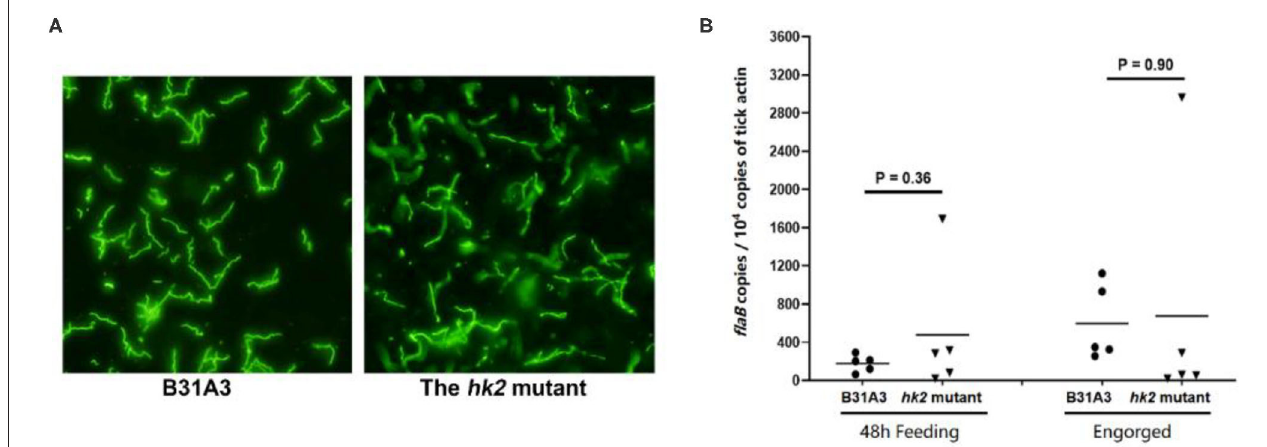
FIGURE 1 | IFA and qPCR analyses of spirochetes in fed larvae. (A) Unfed I. scapularis larvae harboring either the wild type B31A3 or the hk2 mutant were fed on naive C3H/HeN mice, and engorged larvae were subjected to IFA analysis using fluorescein isothiocyanate-labeled anti- B. burgdorferi antibody. Five ticks were examined for each group, and a representative image for each group of ticks is shown. (B) 48h feeding larvae or fully fed larvea were collected and subjected to qPCR analyses. Each data points were generated from the DNA sample extracted from three larvae. The copy numbers of the flaB gene of B. burgdorferi was used for caculating spirochetal numbers, which is nurmalized by 10 4 copies of the tick actin